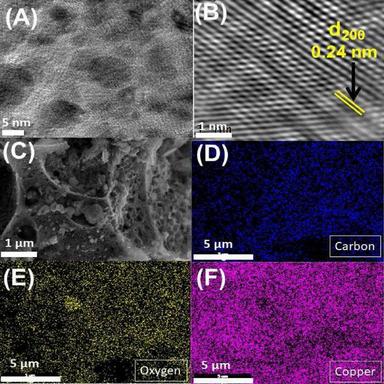
(A) PXRD patterns (B) Raman spectra and (C) FTIR spectra of ACC and Cu-ACC.